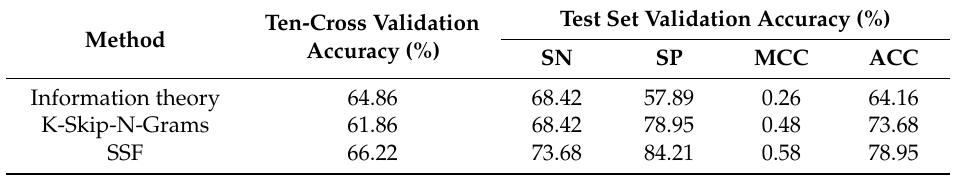
Table 1. The results of using single feature representation methods and the PDB186 dataset.